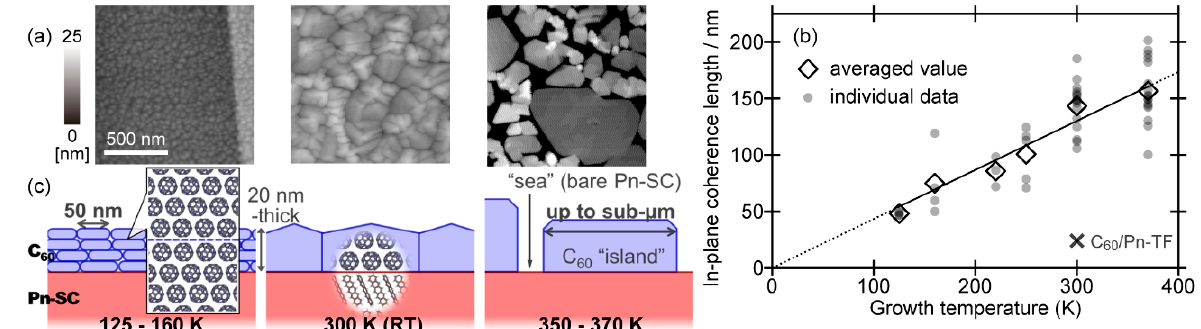
Figure 7. ( a ) AFM micrographs of 20 nm-thick C 60 deposited on a PnSC substrate at various temperatures. ( b ) In-plane mean crystallite size (coherent length) of the 20 nm-thick C 60 deposited on PnSCs plotted as a function of the growth temperature. The value for C 60 on a pentacene thin film (PnTF) is also displayed for comparison. ( c ) Schematic drawings of growth manners of C 60 on PnSC depending on the growth temperature. Cited from [66].